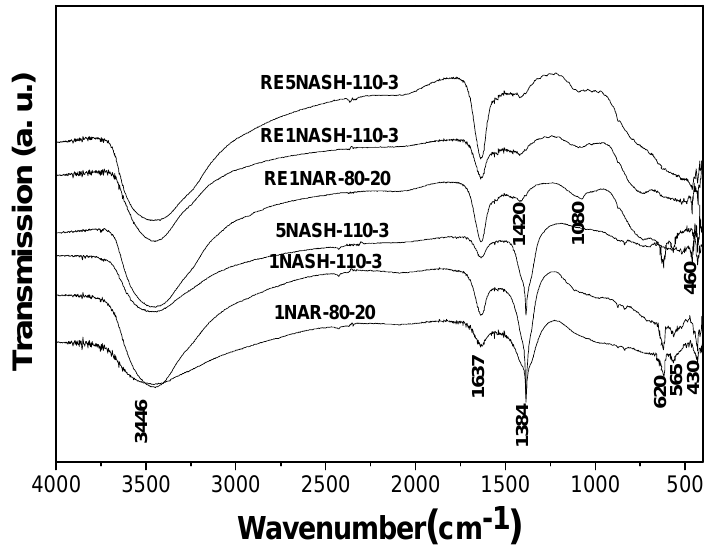
Figure 3. FTIR spectra of Ni/Al HTlcs and Ni-based